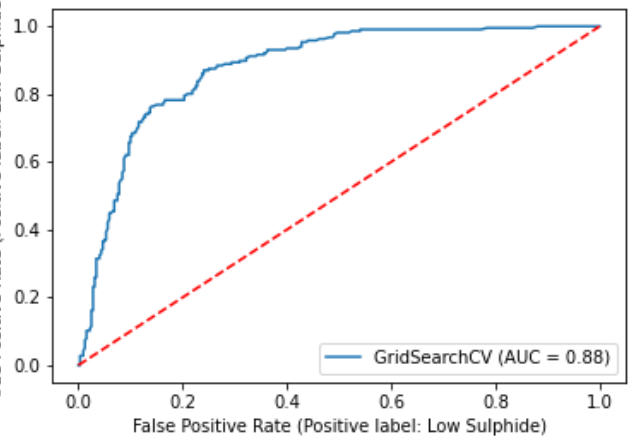
Figure 6. AUC-ROC curve of the RF Model compared with a no-skill classifier.